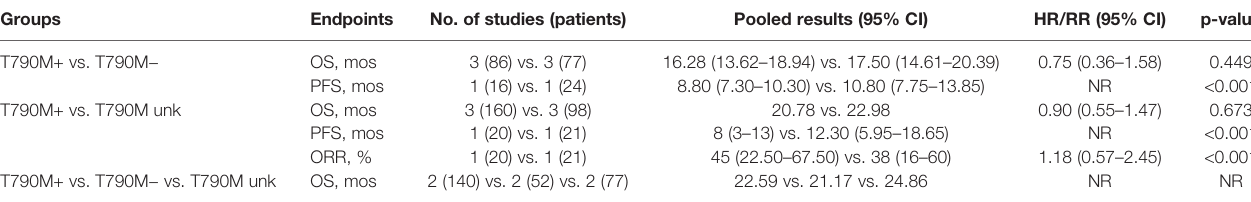
TABLE 4 | Pooled results of survival and response rate for the different T790M statuses with brain metastases. Groups